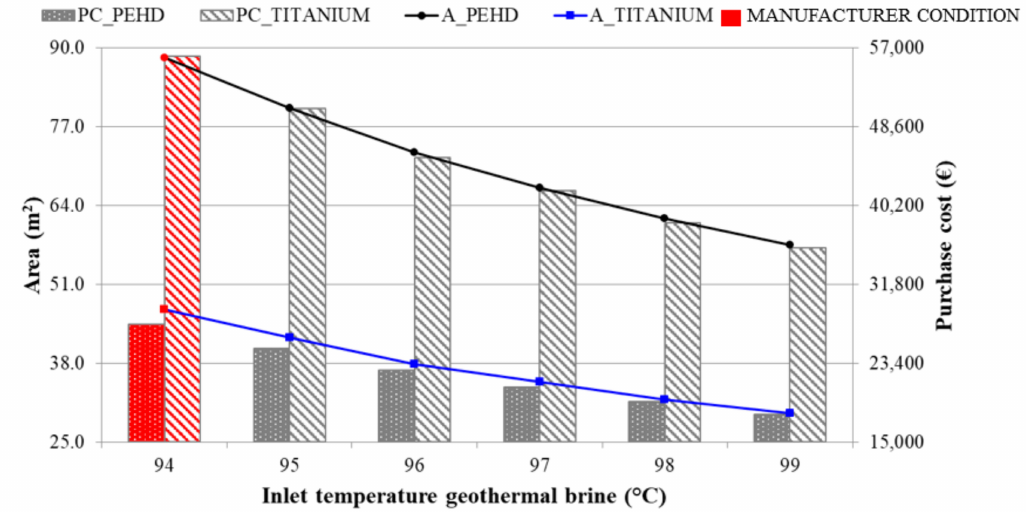
Figure 8. Purchase cost and area of evaporator in PEHD and titanium as a function of inlet temperature of geothermal